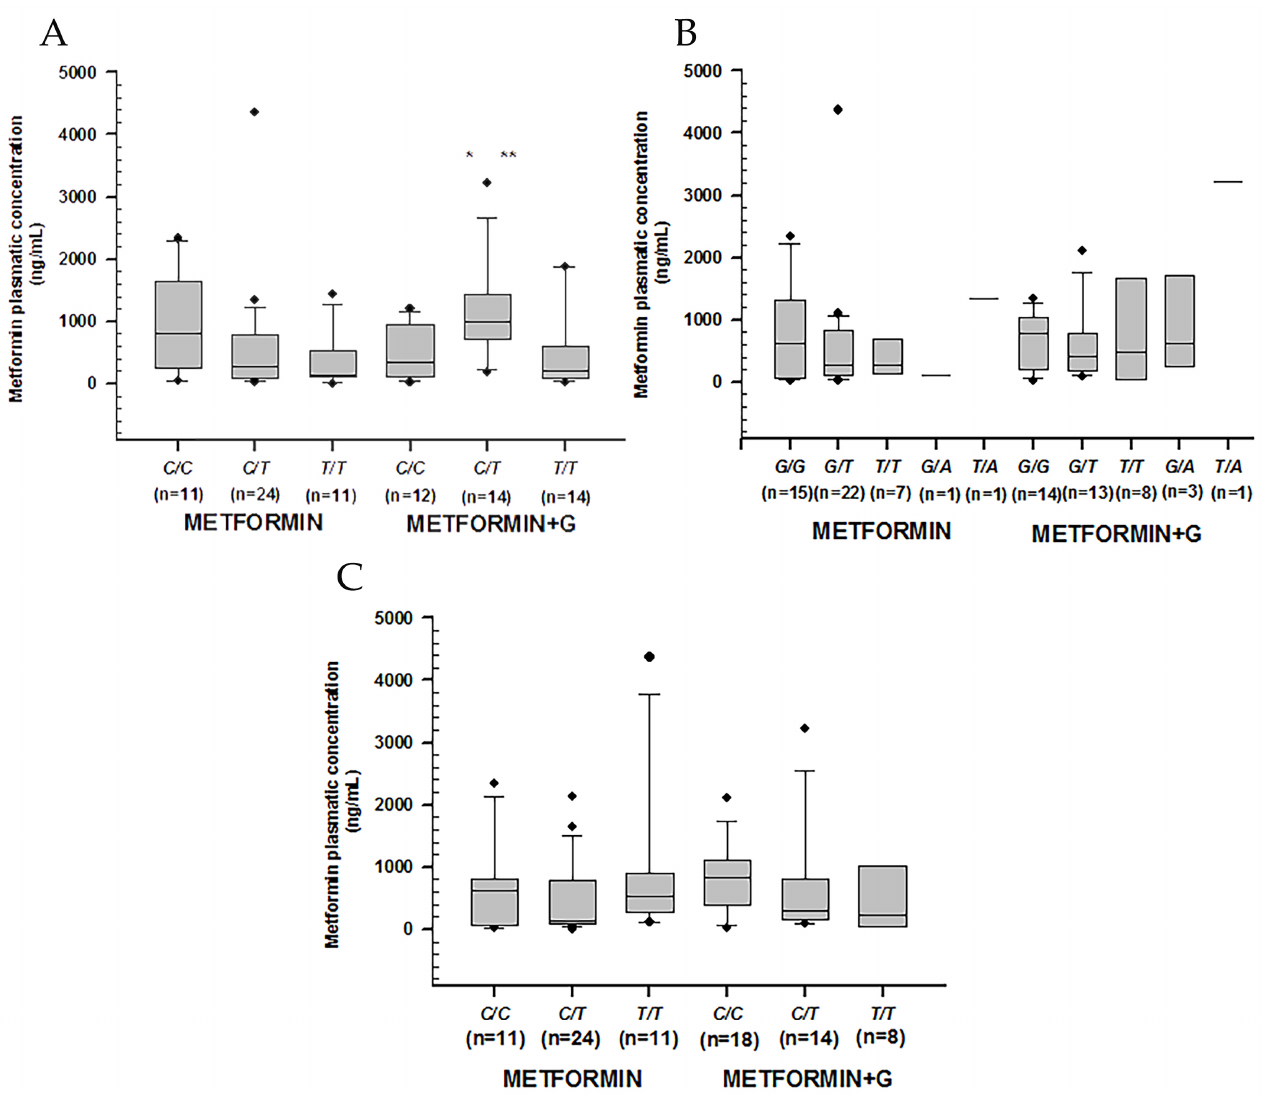
Figure 2. Metformin plasmatic concentration boxplots (ng/mL), including medians, interquartile ranges, and outliers (filled circles). ( A ) rs1128503 ( ABCB1 ). ( B ) rs2032582 ( ABCB1 ). ( C ) rs1045642 ( ABCB1 ). Metformin to the left, metformin + glibenclamide to the right according to genotype. Only C/T of rs1128503 reported both extra-group (metformin + glibenclamide) (** p = 0.002) and intra-group (metformin) statistical difference (* p = 0.007).